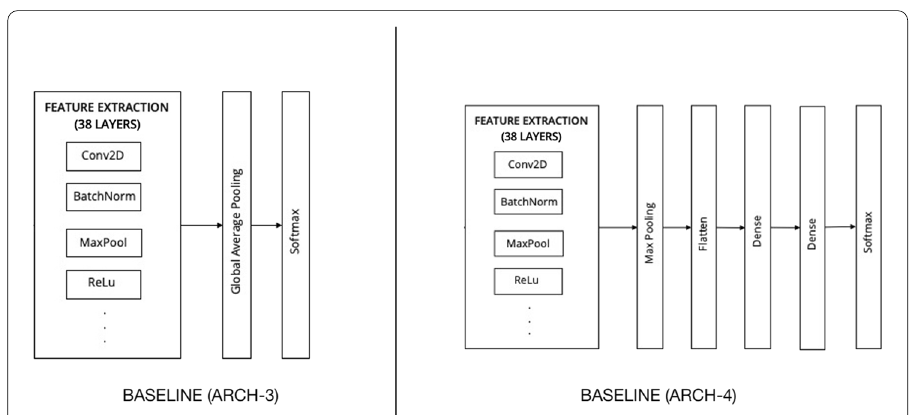
Fig. 3 Baseline architecture ARCH-3 (left) with global AVG and ARCH-4 (right) with